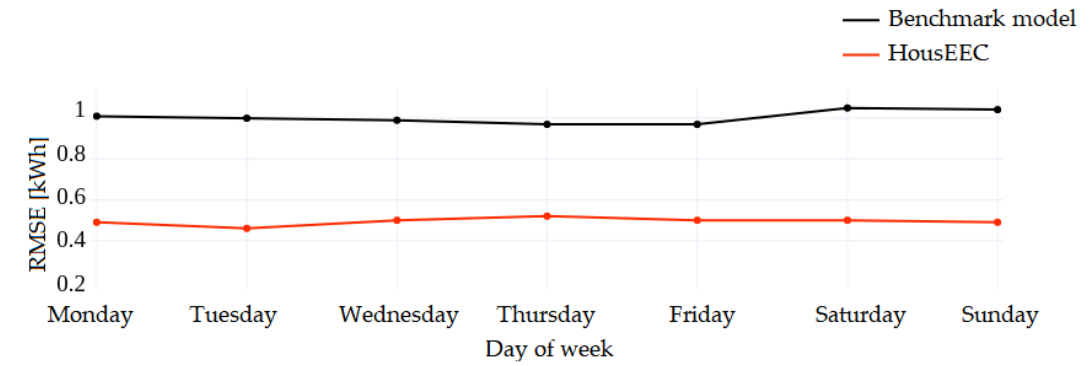
Figure 9. Root-mean-square error (RMSE) for each day of the week.